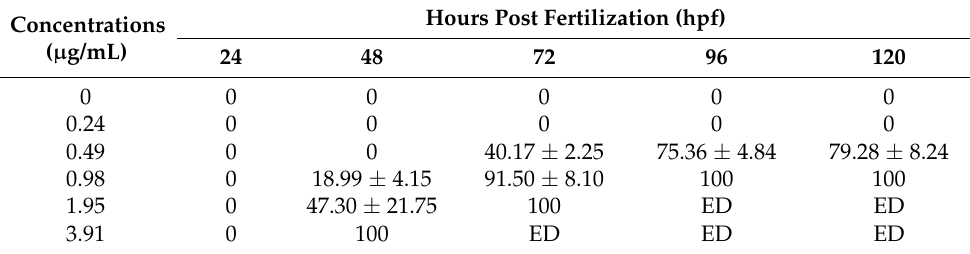
Table 2. Teratogenic effect of ZO essential oil on zebrafish embryos at 24, 48,72, 96, and 120 hpf, which had received ZO essential oil at dose of 0.24, 0.49, 0.98, 1.95, and 3.91 µg/mL, and 0.1% DMSO (control) at 24, 48, 72, 96, and 120 hpf. Descriptive data show the percentages (mean ± SD) of terato- genic zebrafish embryos from three independent experiments ( n = 60 embryos/group). ED = embry- onic death.